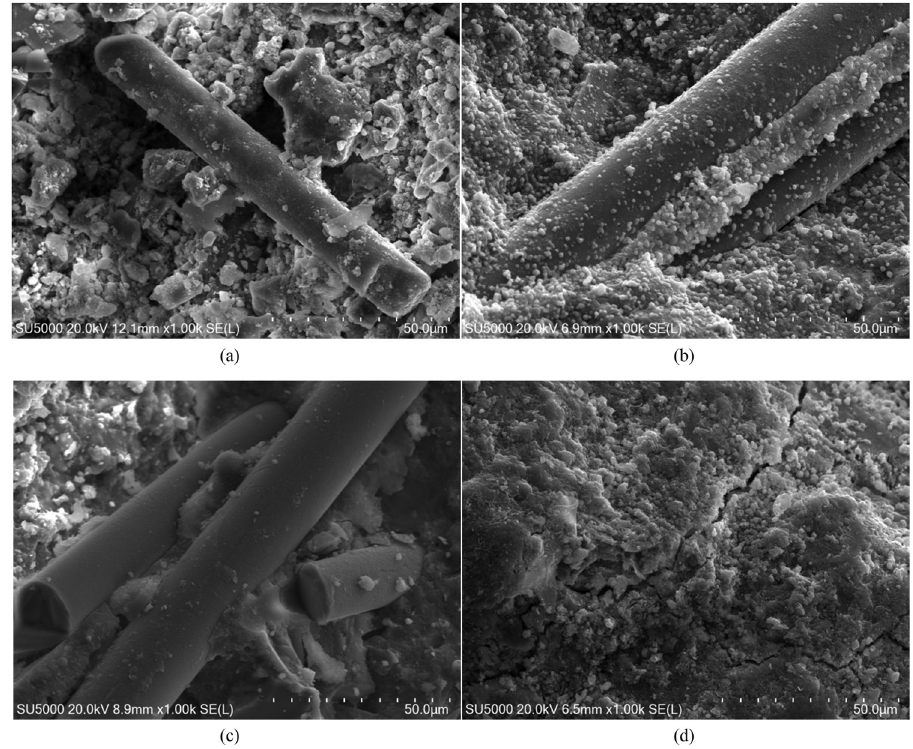
Figure 25: The bonding between BF and cement matrix under SEM measuring. ( a ) BF12 - 0.1%, ( b ) BF12 - 0.2%, ( c ) and ( d ) both show BF12 - 0.3%, which does not need to be modi fi ed